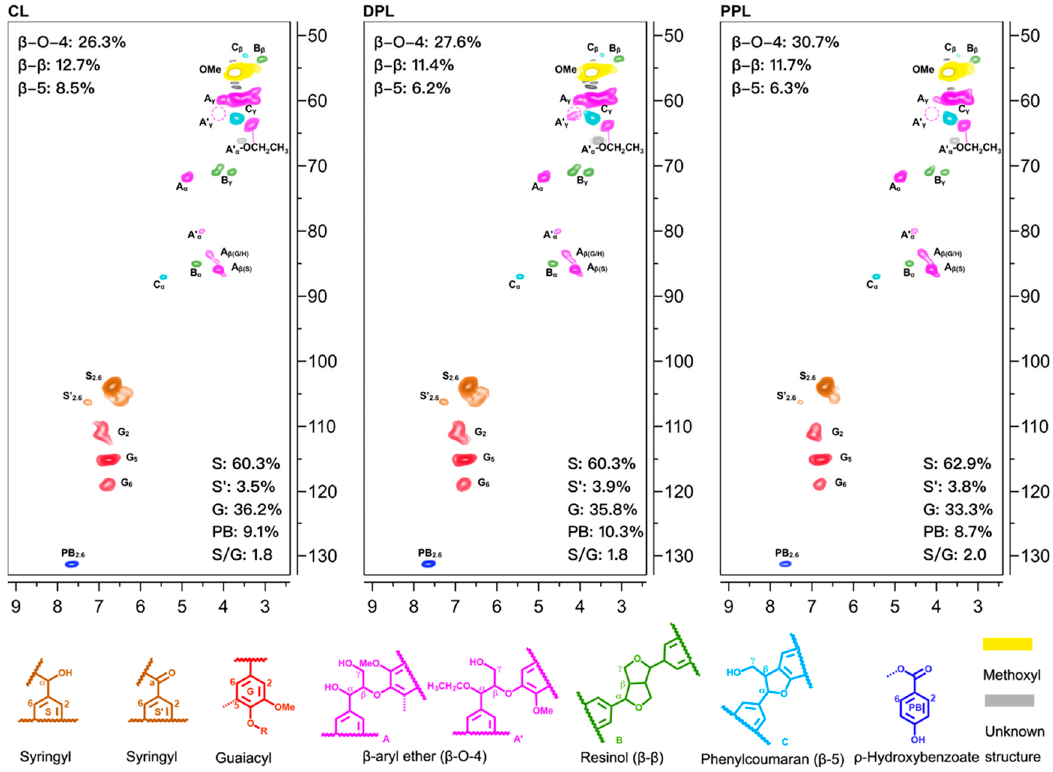
Figure 2. Partial 2D-HSQC NMR spectra of CL, DPL and PPL. Volume integrals are given for the lignin side-chain structures, which are color-coded to match their signal assignments in the spectrum.